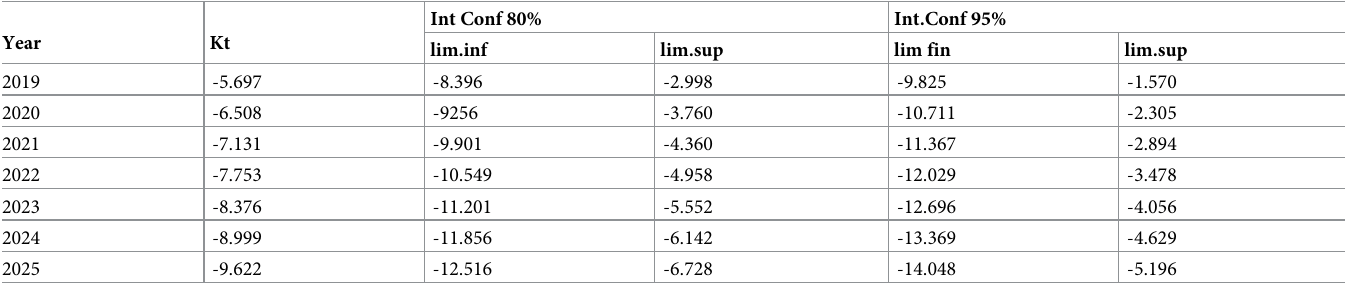
Table 7. k estimated for females (2019–2025) by the ARIMA model (0, 2, 3), with a confidence interval of 80% and t